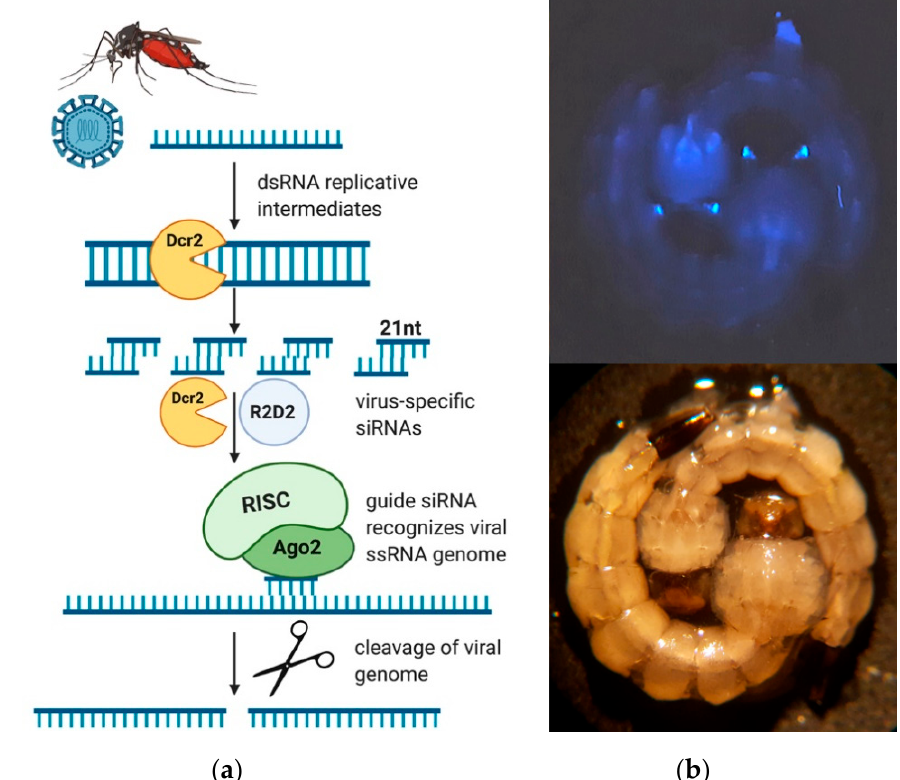
Figure 1. Transgene-mediated resistance to ZIKV in Ae. aegypti . ( a ) Schematic outline depicting the siRNA-dependent antiviral pathway in Ae. aegypti . Single-stranded RNA (ssRNA) viruses form double-stranded RNA intermediates during replication. Dicer-2 processes dsRNAs into 21nt virus-specific siRNAs. The guide siRNA strand associates with the RISC complex and escorts the endonuclease Ago-2 to complementary sequences in the cell. Ago-2 cleaves the viral ssRNA genome in a sequence-specific manner. Figure created with biorender.com. ( b ) ( top ) Transgenic mosquito larvae expressing ECFP from the photoreceptor-specific promoter 3xP3, enabling marker-based identification by fluorescent microscopy and selection of transgenic individuals. ( bottom ) Transgenic larvae under white light. Dcr2 = dicer-2; RISC = RNA induced silencing complex; Ago2 = Argonaute-2. Table 1. Testing of sgRNAs for genome editing rates in the Chr2:321382225 locus of Ae. aegypti. Injection Mix Embryos Injected